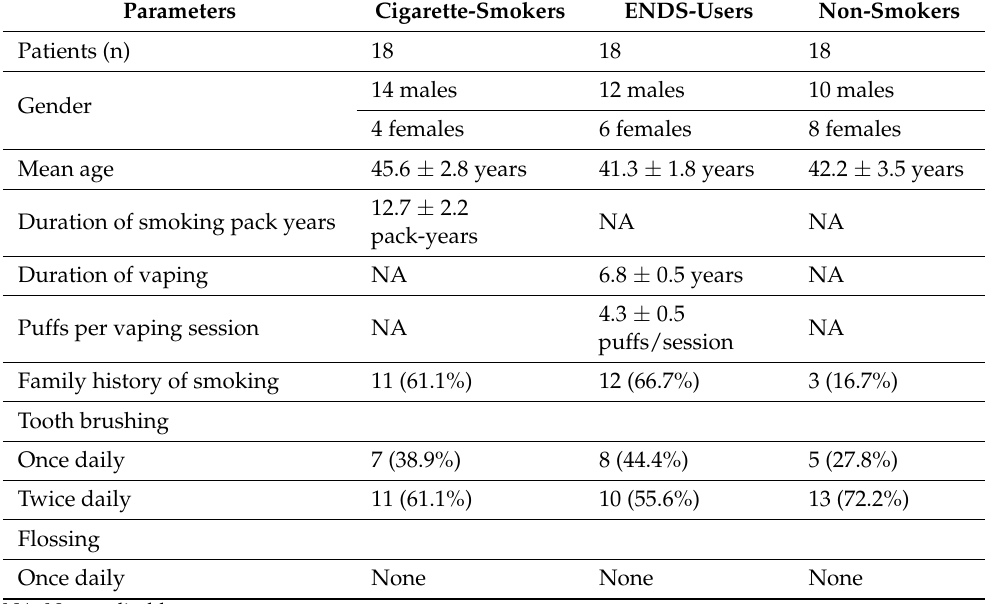
Table 1. Demographics of the study